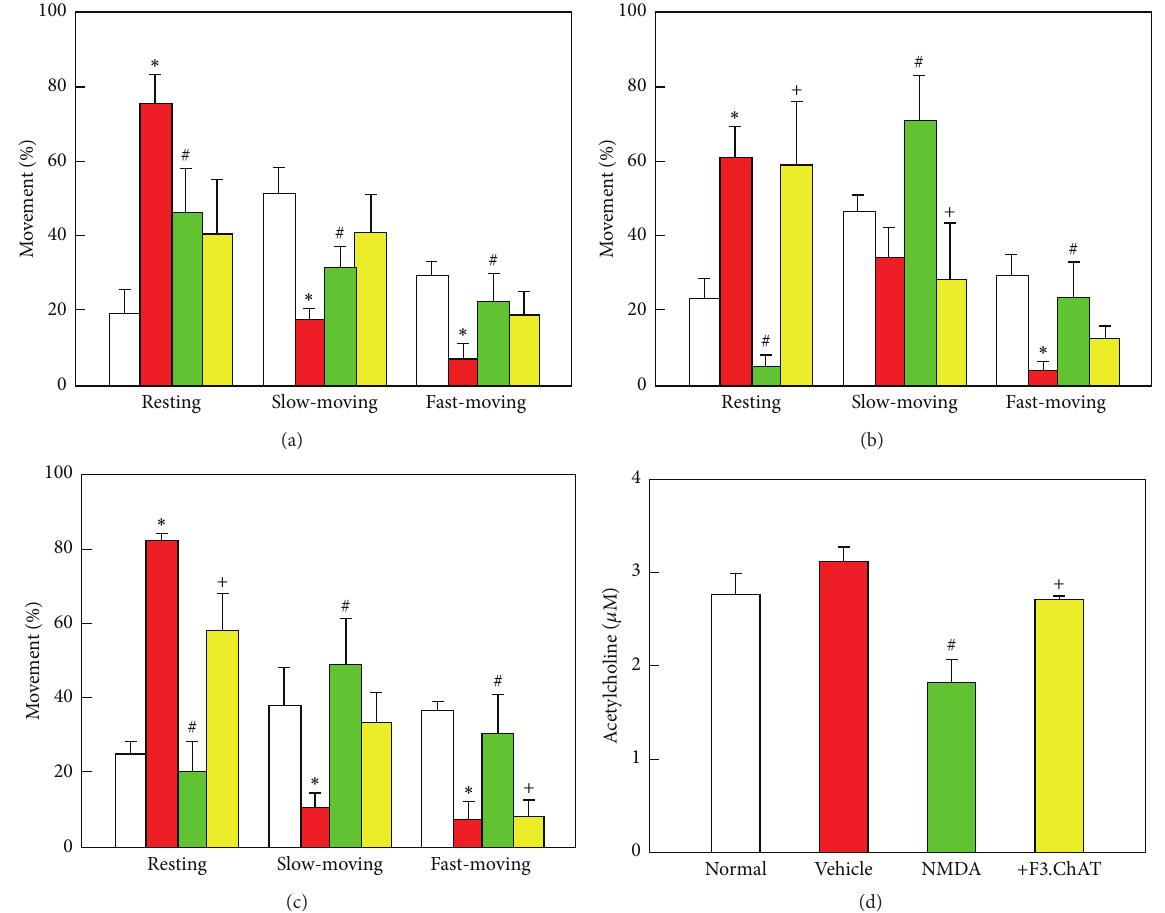
Figure 3: Locomotor activity of rats that encountered cat odor (a–c) and acetylcholine concentration (d). Spontaneous movements (resting and slow-moving and fast-moving times) were analyzed immediately before (a) and 2 weeks (b) and 4 weeks (c) after F3.ChAT cell transplantation following N-methyl-d-aspartate (NMDA) injection ( − 2 weeks), and acetylcholine was analyzed in cerebrospinal fluid 4 weeks after transplantation (d). White, normal environment (without cat odor) + vehicle (saline for NMDA and cells); red, cat odor + vehicle; green, cat odor + NMDA + vehicle; yellow, cat odor + NMDA + F3.ChAT cells. ∗ Significantly different from normal control ( 𝑃 < 0.05 ). # Significantly different from vehicle control ( 𝑃 < 0.05 ). + Significantly different from NMDA alone ( 𝑃 < 0.05